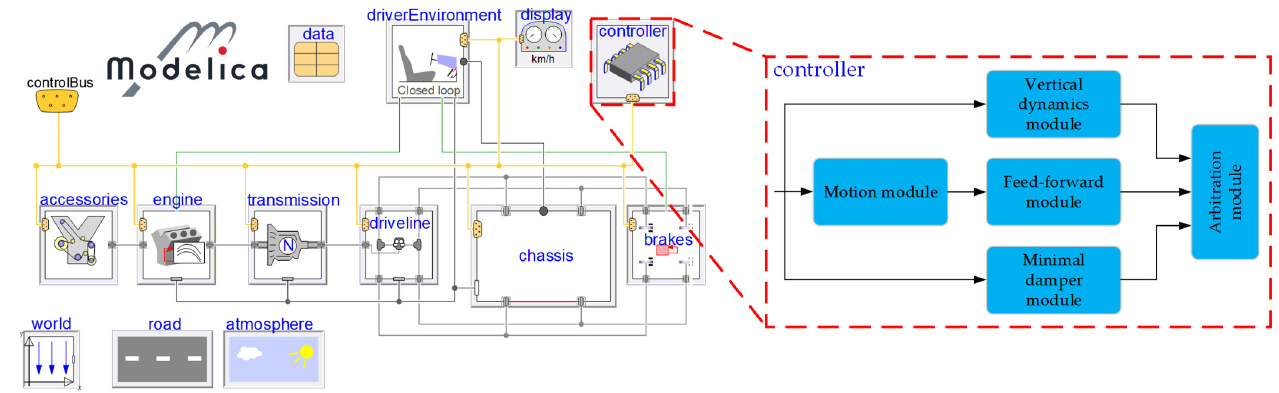
Figure 6. Overview of the closed-loop high-fidelity Modelica model of a vehicle including a semi-active damping controller.